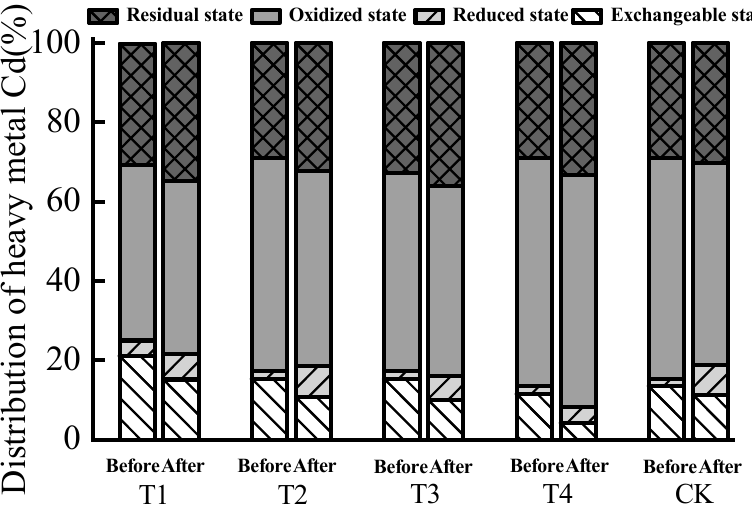
Figure 3. Distribution rate of various forms of Cd before and after biogas residue composting.